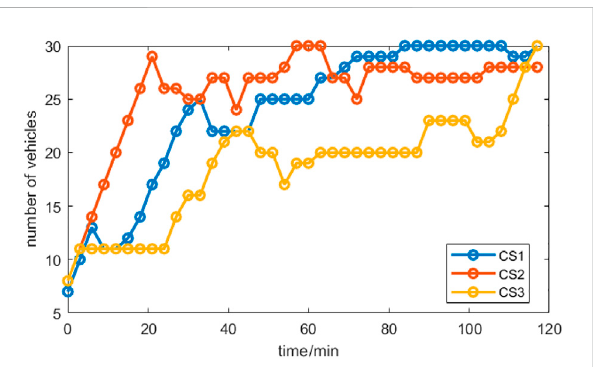
FIGURE 8 Changes in the number of vehicles at the nodes of charging